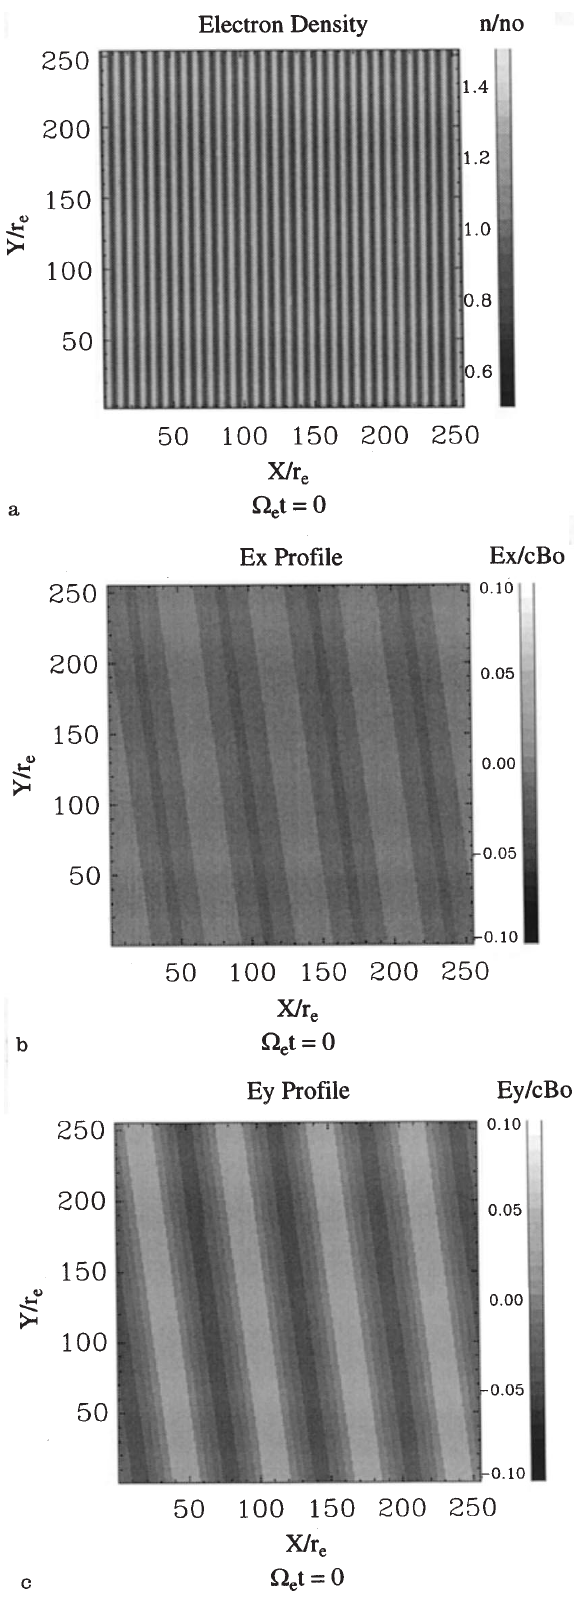
Fig. 3a–c. Contour plots of a electron density n e , b perpendicular electric field E x , and c parallel electric field E y in the x - y simulation plain at t =